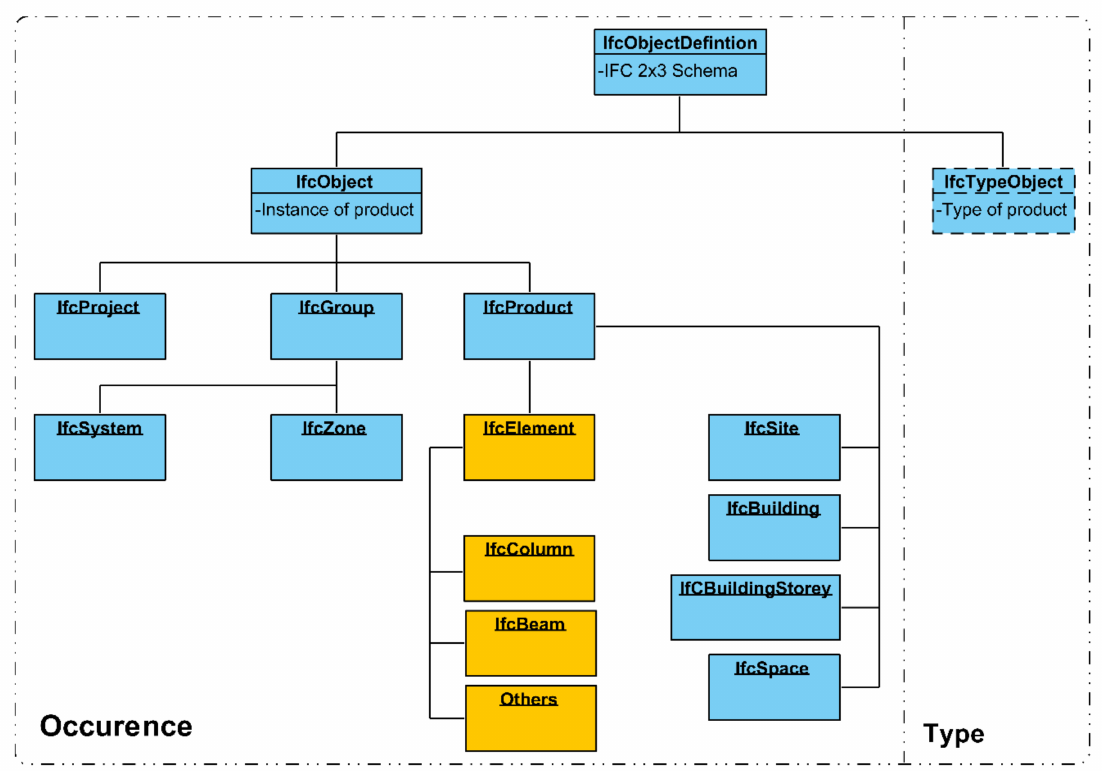
Figure 1. Industry foundation classes (IFC) 2 × 3 Schema Map including spatial